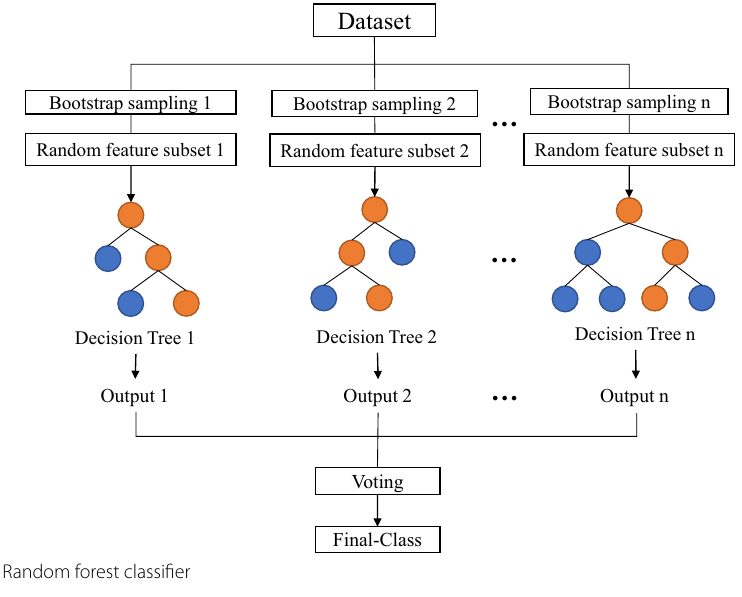
Fig. 2 Random forest